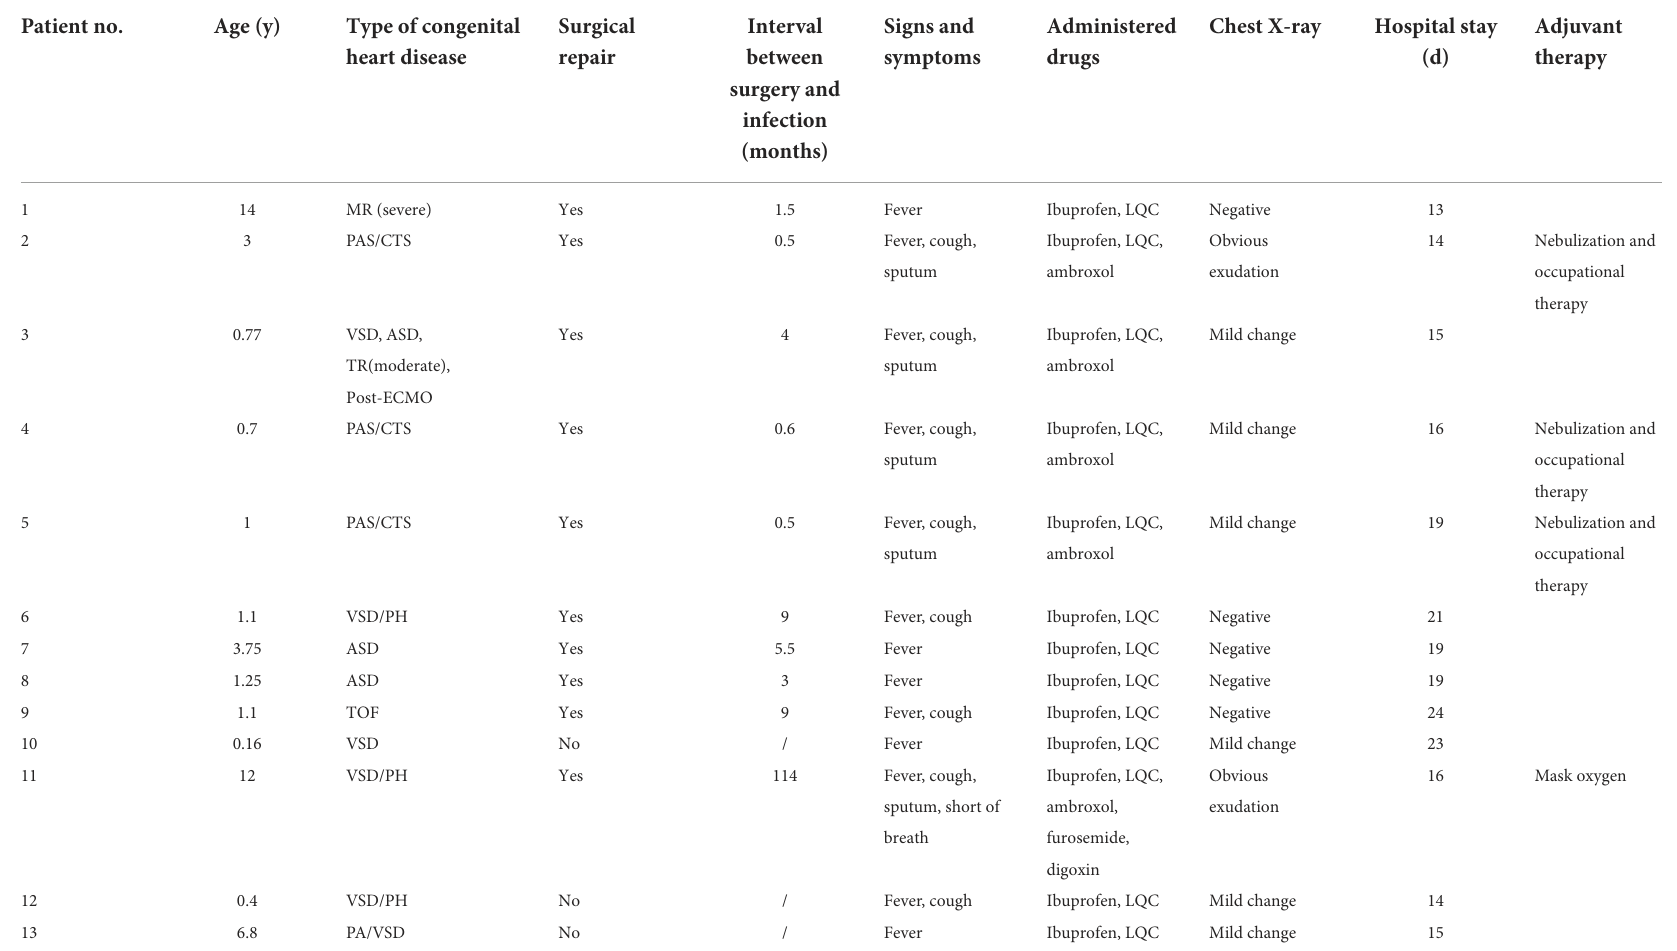
TABLE 2 Clinical and paraclinical findings of the patients with congenital heart disease. Patient